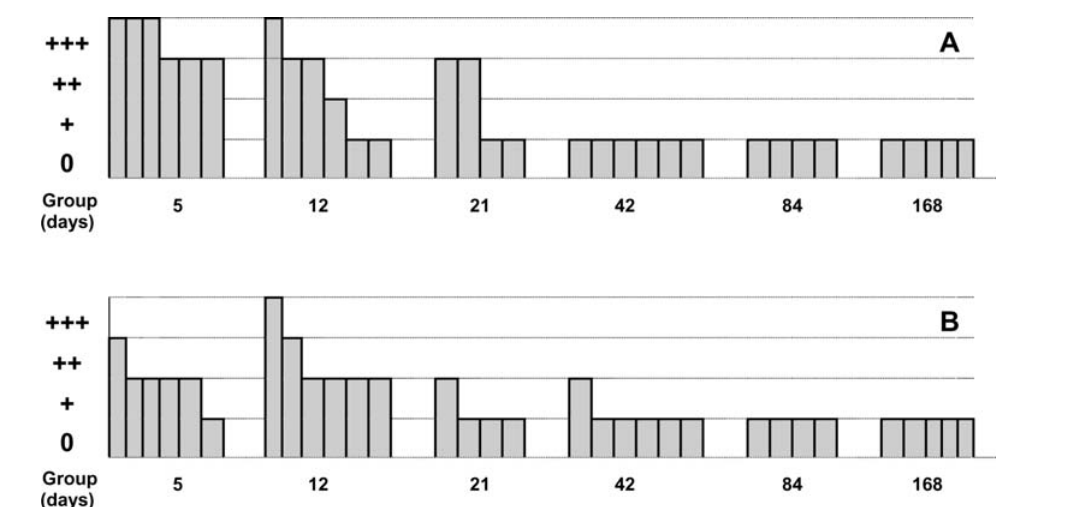
FIGURE 7 - Macroscopic vascular phenomena in keloid grafted fragments. Representation of macroscopic events of the groups, by periods of 5, 12, 21, 42, 84 and 168 days, of the observations related to graft circumjacent vascularization (A) and to the presence of vascular branch towards the graft